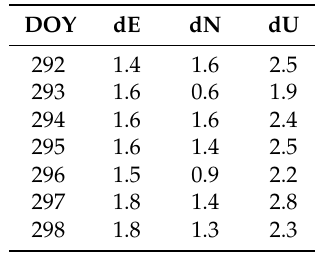
Table 7. Comparison of BDS and GPS static solutions in weak multipath station (unit: mm). dE, dN and dU represent the difference between BDS and GPS static baseline solutions.